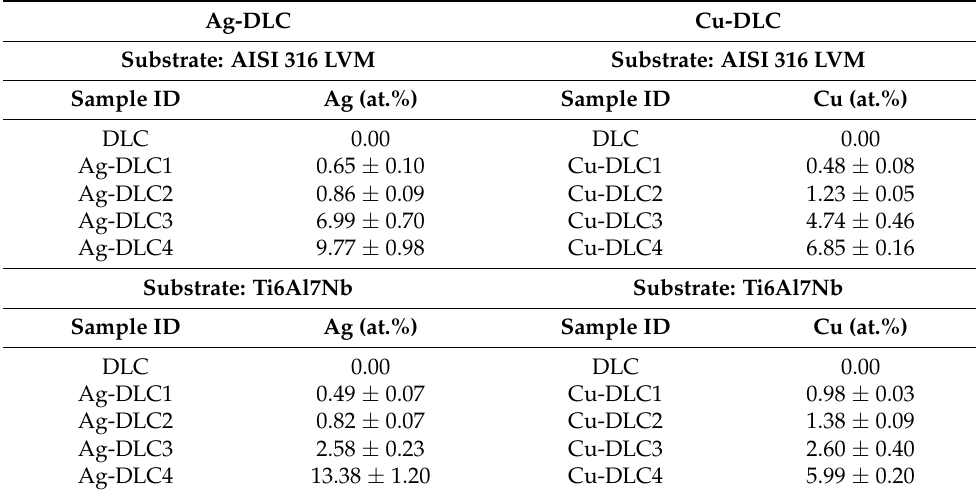
Table 2. Surface amount of admixtures in X-DLC (X stands for additive element (Ag or Cu)) coating evaluated by means of XPS examination.